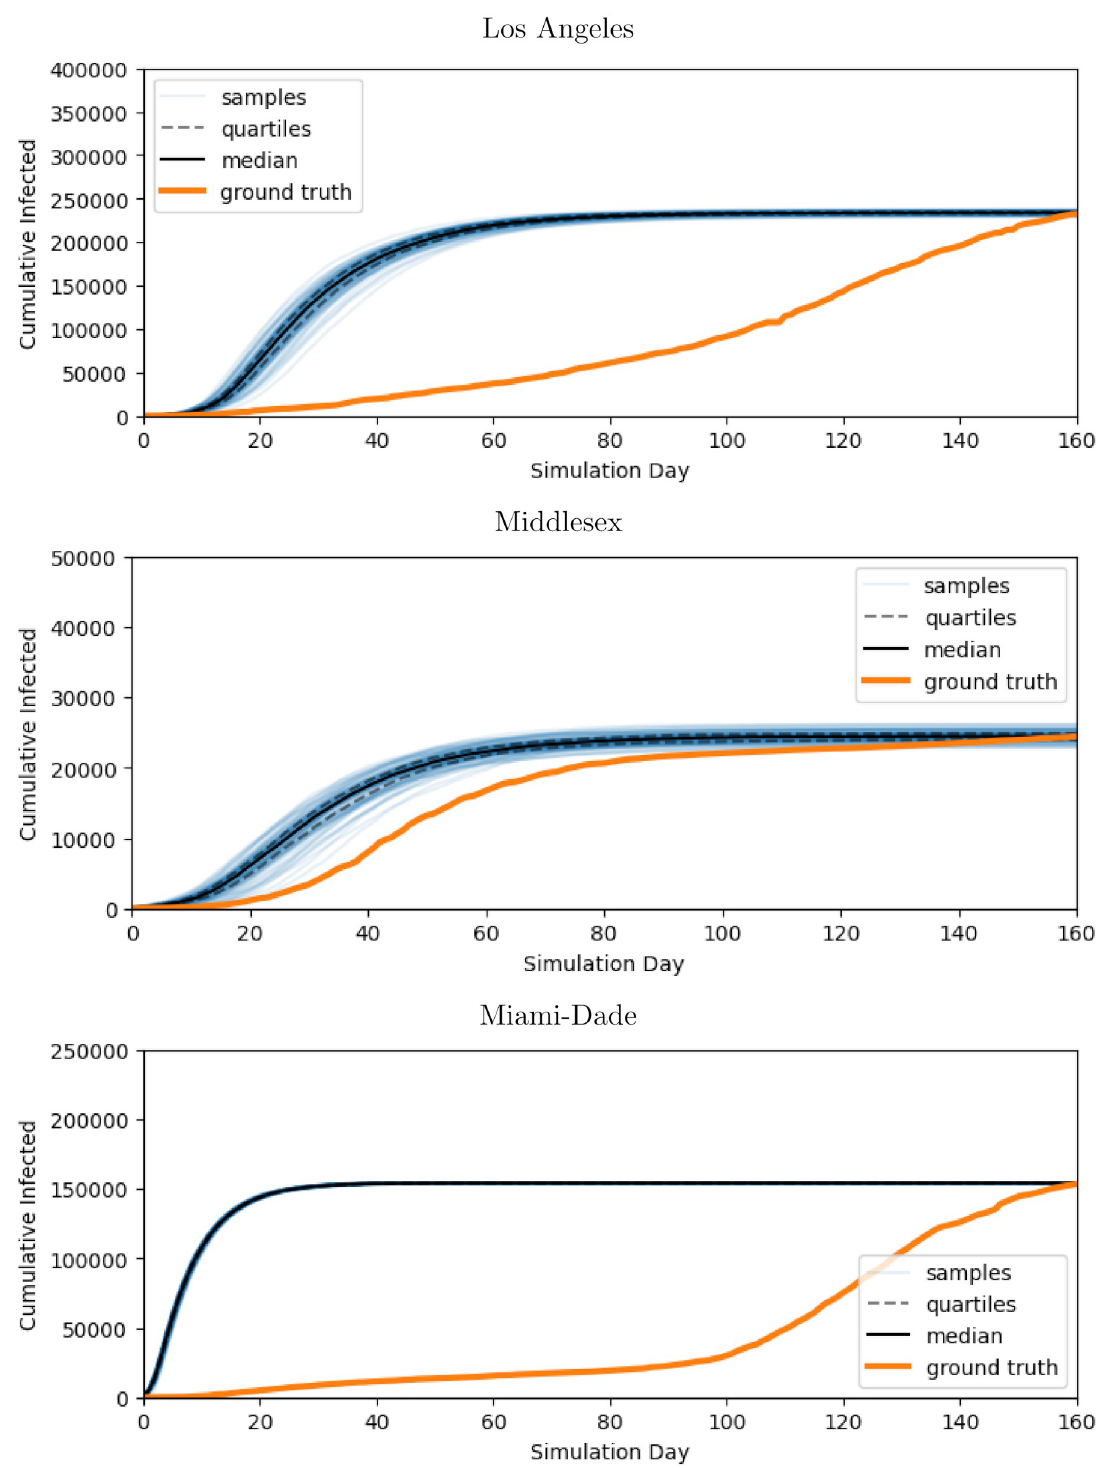
Fig 5. R -analytic parameter inference baseline. R t fits well for some data (such as Middlesex County above), it fits poorly much of the time.